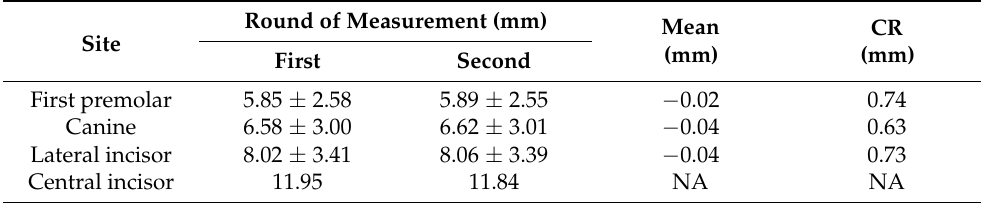
Table 4. Variability in measurement of distance between the MIC and the tooth apex.